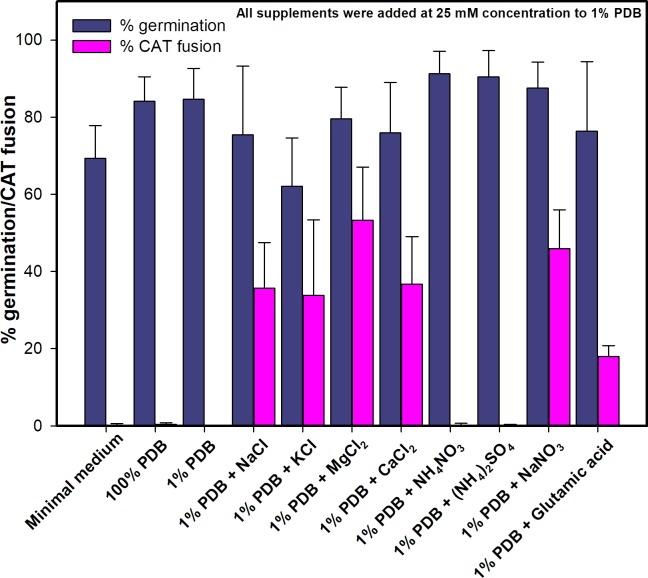
Germination and CAT fusion of microconidial and macroconidial germlings in different media.CAT fusion was only observed in 1% PDB supplemented with various chemicals/nutrients at 25 mM (NaNO3, CaCl2, NaCl, MgCl2, KCl or monosodium salt of glutamic acid). 1x106 spores/ml used.